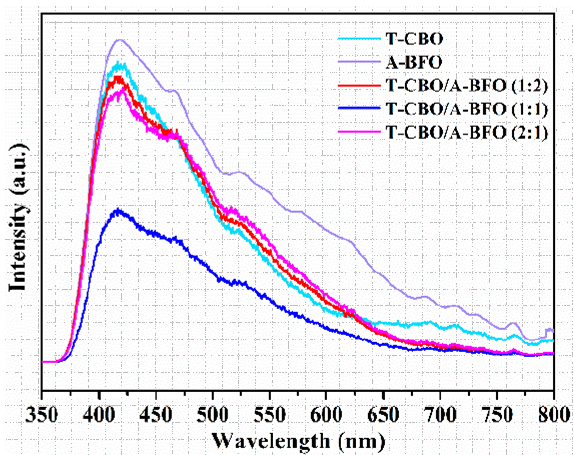
Figure 7. PL spectra of T-CBO, A-BFO, T-CBO/A-BFO (1:2), T-CBO/A-BFO (1:1), T-CBO/A-BFO (2:1).